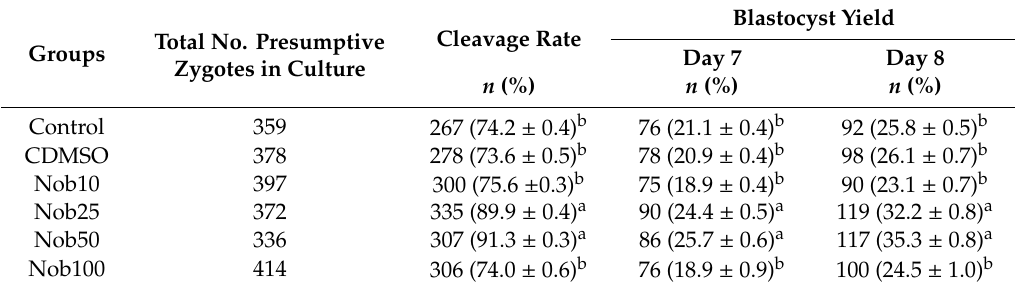
E ff ect of nobiletin on in vitro maturation of bovine oocytes and subsequent Table 2. Effect of nobiletin on in vitro maturation of bovine oocytes and subsequent embryonic embryonic development.